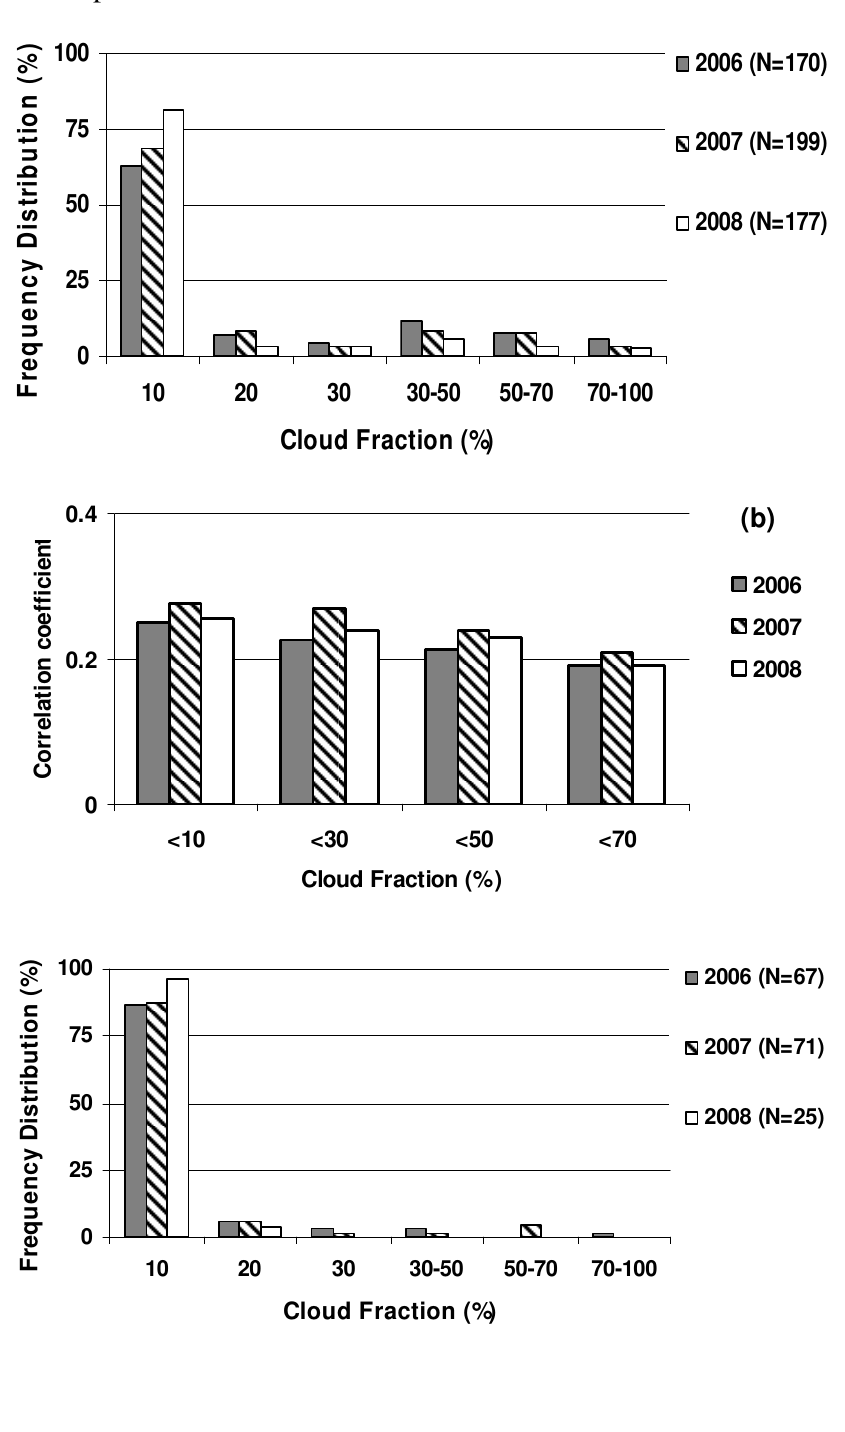
Figure 7. (a) Normalized frequency distribution histogram versus CF bins for the PM-AOT data set of Arnesano in 2006, 2007, and 2008 . (b) Histogram of linear correlation coefficients retrieved by taking into account PM-AOT data sets characterized by CF <10%, 30%, 50%, and 70%, respectively, in 2006, 2007, and 2008. (c) Normalized frequency distribution histogram versus CF calculated by considering all clear-sky MODIS measurements referring to Arnesano in 2006, 2007, and 2008. N represents the total number of used data